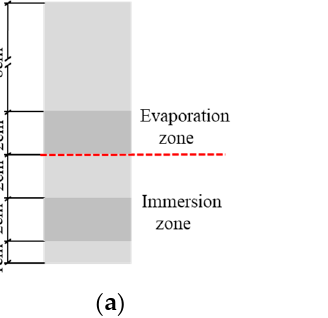
Figure 4. Pore size distribution in specimens cured for 56 days. The total porosity of the specimens gradually increased with increasing in limestone addition. As the limestone addition increased from 10 wt. % to 30 wt. %, the total porosity was increased by 0.4% (LS10), 3.7% (LS20) and 6.6% (LS30), respectively. It was found that the pore radius of specimen containing limestone were coarsened. Specifically, the per- centage of pores <100 nm in LS specimens decreased slightly, while the proportion of larger pores (>100 nm) increased by 2.7% (LS10), 6.1% (LS20), and 10.4% (LS30), respec- tively. It has shown [26] that the addition of 8 wt.% coarse limestone powder (>10 μ m) to the cement was able to significantly increase the >100 nm pores in the cement paste and increased the total porosity of the cement paste. This may be related to the fact that intro- ducing 30 % inert limestone powders produced significant “dilution effect”. This resulted in a reduced cement content and thus increased in the effective w/c of the test mix, leading to the formation of coarser pores. According to the capillary adsorption principle [27] (Equation (1)), the height of capillary adsorption rise is determined by the pore radius. The smaller the pore size, the higher the height of capillary adsorption. With the increase of limestone powder addition, the pores in the specimen are coarsened, and therefore, the capillary rise height in the evaporation zone is significantly reduced. This might be re- sponsible for much slight damage of LS samples in the evaporation zone. On the other hand, the larger pores also facilitate the SO 42- diffusion [15] (Equation (2)), which causes more serious sulfate attack in the immersion zone of LS specimens than in the evaporation zone.